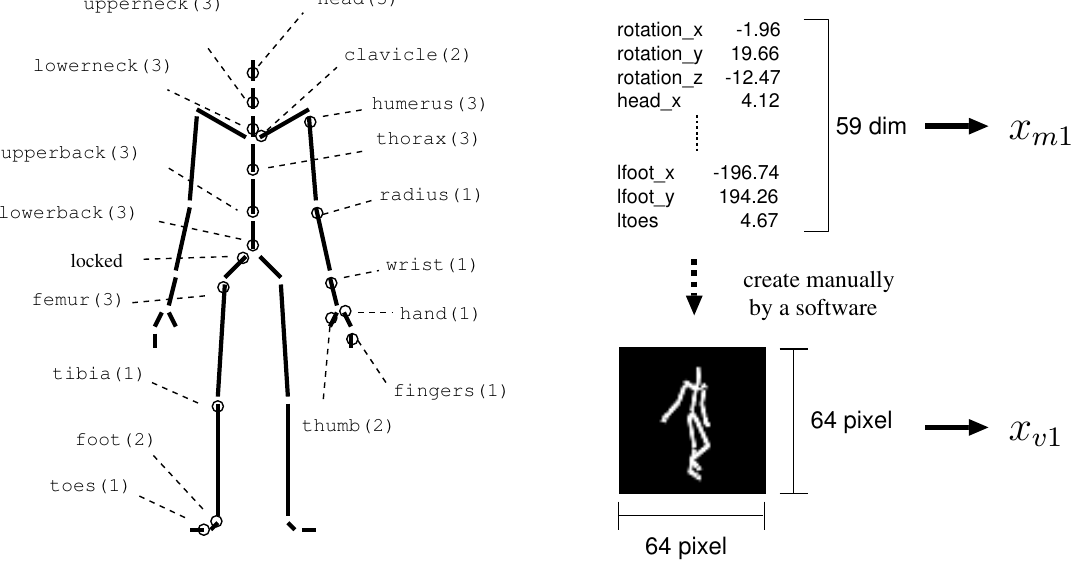
Figure 4: Left: Joints and degrees of freedom of the body skeleton in the motion patterns. Right: Example of 1-shot motion and visual data (denoted by x m 1 and x v 1 respectively). The motion and visual image sequences consist of multiple data of this.